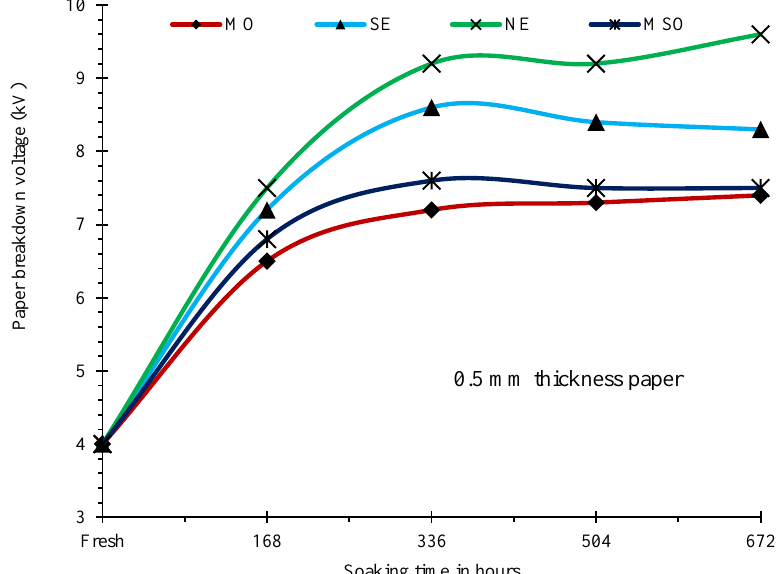
Figure 5. Wetting characteristics of 0.5 mm thickness papers without thermal stressing in various insulating.